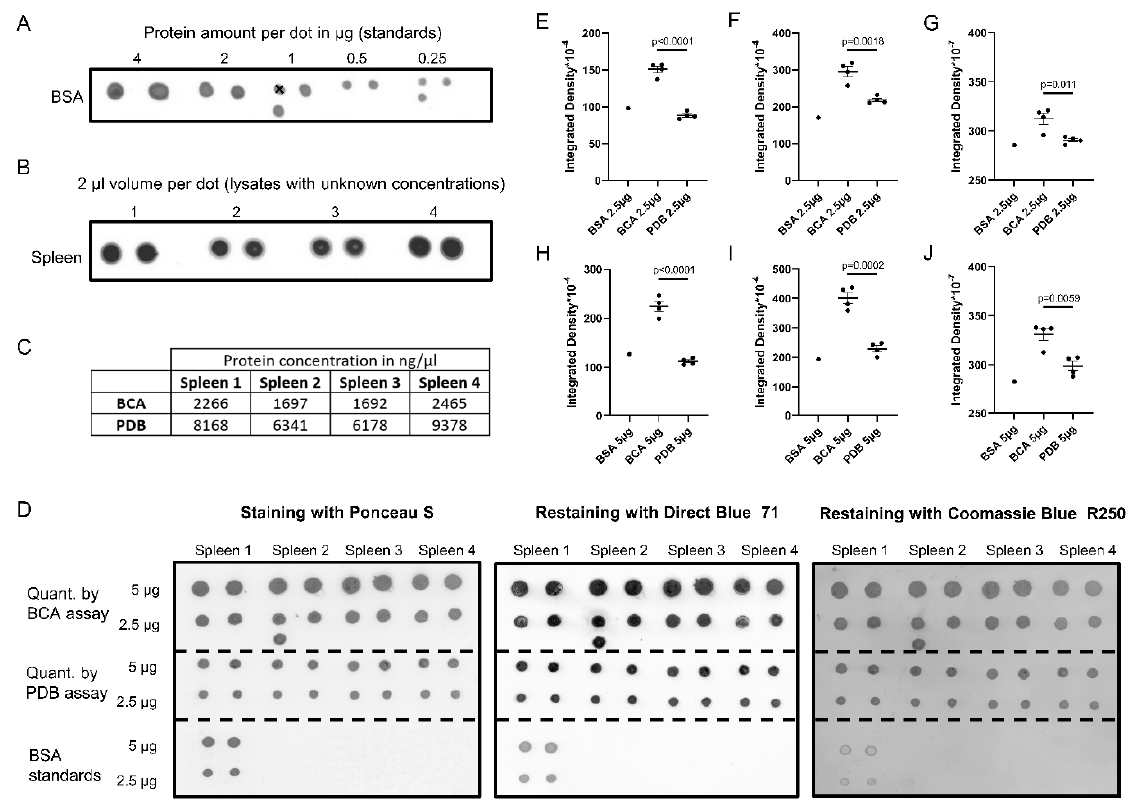
Figure 3. Underestimation of protein concentrations by the BCA assay. ( A ) Ponceau S-stained dot blot. Variable volumes of a BSA solution (2 µg/µL) containing indicated BSA amounts were spotted onto a nitrocellulose membrane. A cross indicates an incorrectly applied sample that was excluded for the analysis. ( B ) Ponceau S-stained dot blot. A quantity of 2 µL of spleen lysates from four mice was spotted in duplicates onto a nitrocellulose membrane. ( C ) Calculated protein concentrations of the spleen samples based on either the PDB or the BCA assay. ( D ) Retest of the protein concentrations of the spleen samples by different staining of the dot blot. Spleen samples containing 5 or 2.5 µg of total proteins (calculation based on either the PDB or the BCA assay), in addition to the BSA standards (2 µg/µL), were spotted in duplicate onto a nitrocellulose membrane. The blot was sequentially stained with Ponceau S, Direct Blue 71 and Coomassie Blue R250, with destaining between stainings. The integrated density values were then plotted: ( E , H ) for Ponceau S staining; ( F , I ) for Direct Blue 71 staining; ( G , J ) for Coomassie Blue R250 staining. Error bars indicate SEM. p -values were calculated using Student’s t -test.